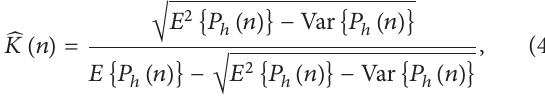
Figure 5: CDFs of the 𝐾 -factor in different propagation